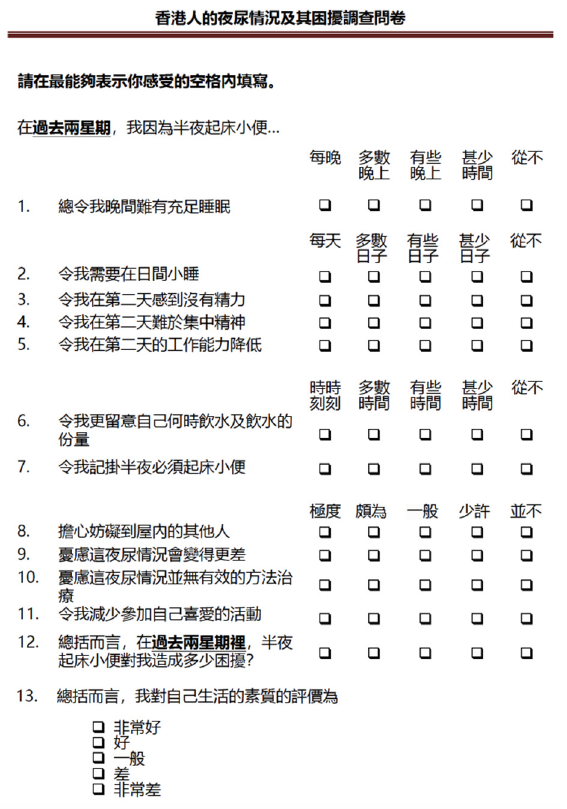
Figure A1. The Hong Kong Cantonese version of the Noctruia Quality of Life module of the International Consultation on Incontinence Modular Questionnaire (ICIQ-NQoL). This version is translated by the research team and the first time appeared in